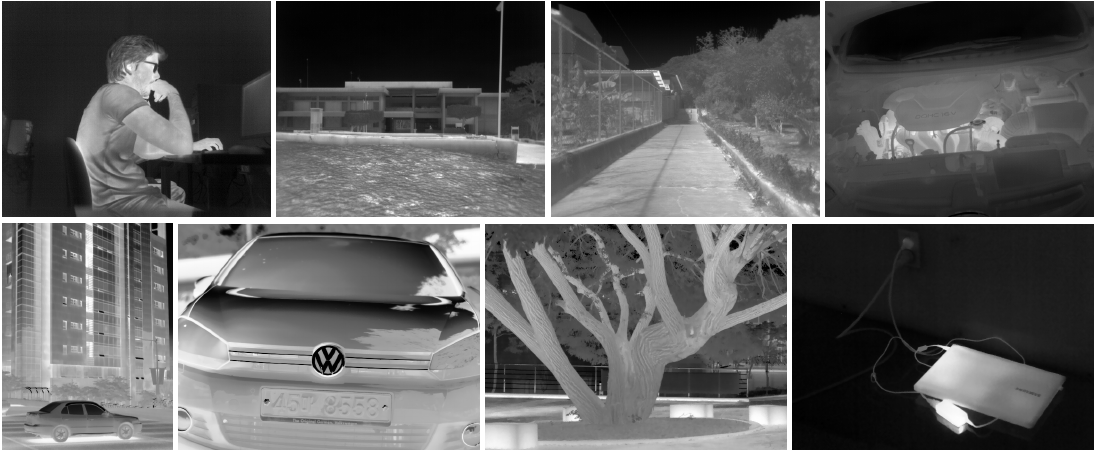
Figure 6. Examples of test dataset (top: from [12]; bottom: from [29]).